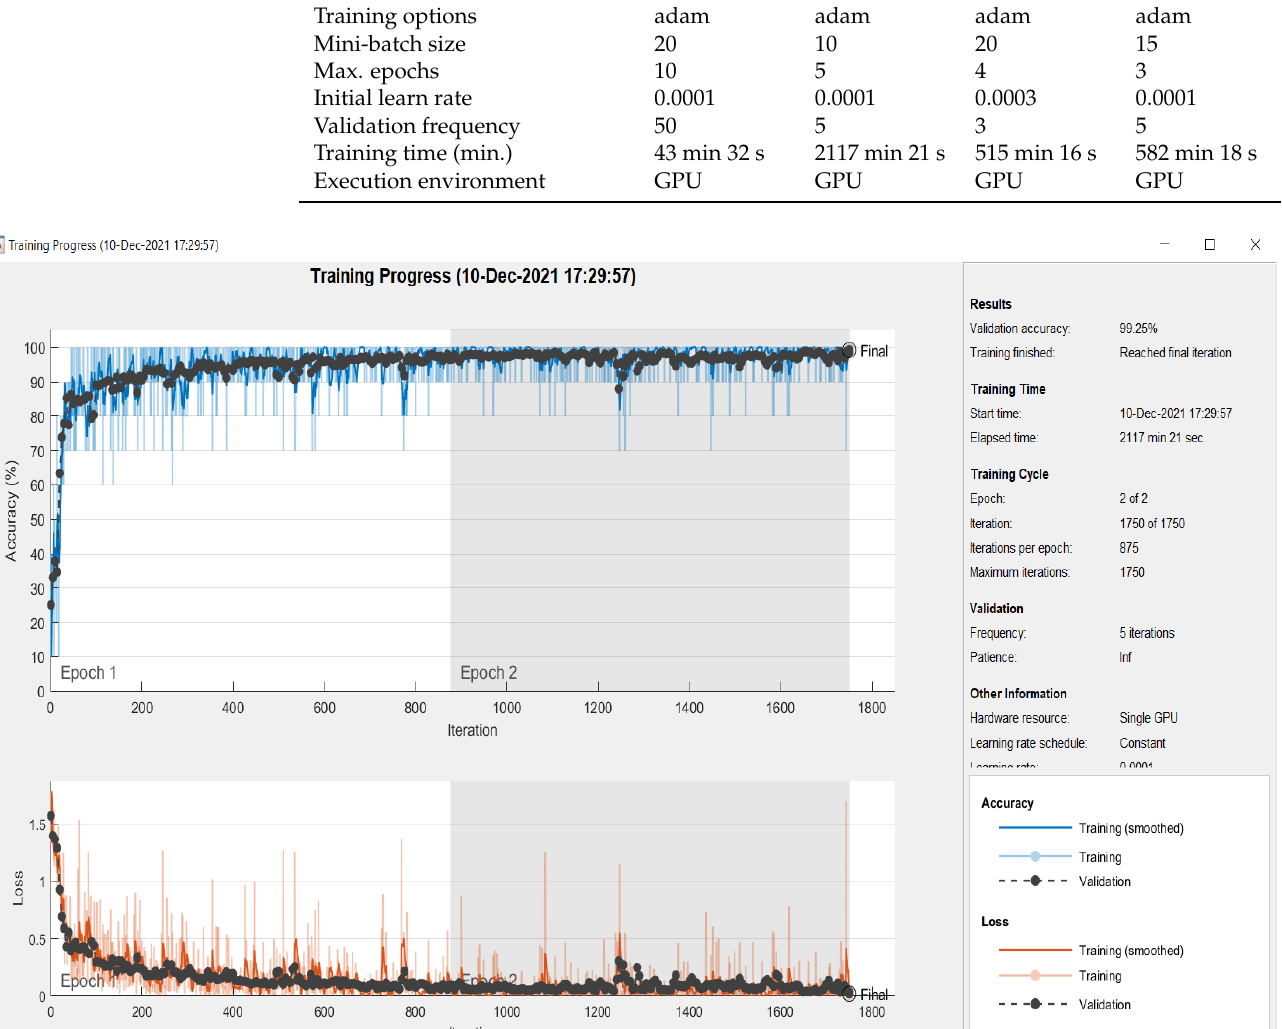
Table 4. The results of the CNN models used on the microscopic blood sample dataset.